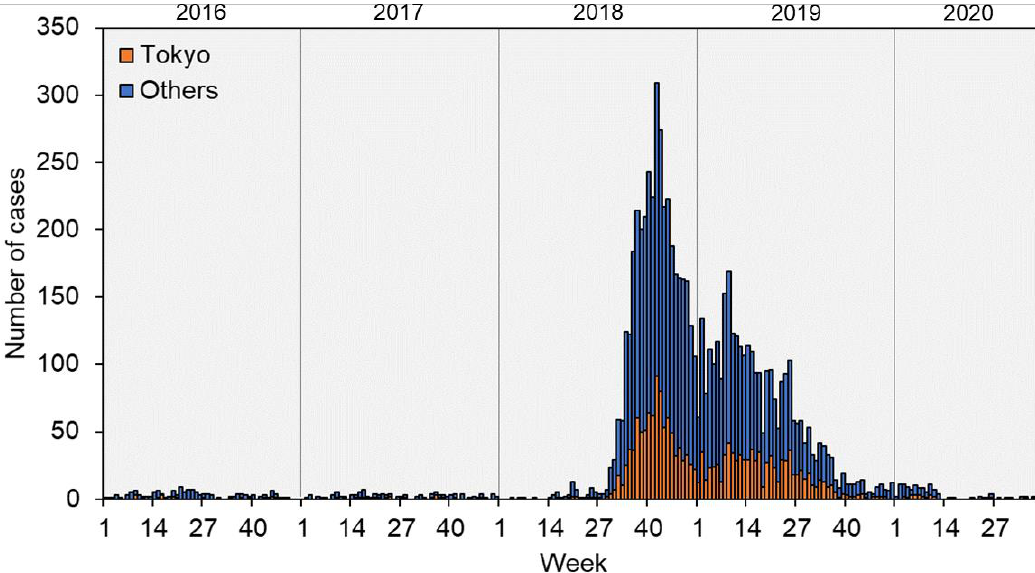
Figure 2. Epidemiological trend of rubella in Tokyo and all of Japan, by week, in 2016–2020. The orange represents the number of reported measles cases in Tokyo, while the blue indicates reported rubella cases outside Tokyo. In 2020, only weeks 1–39 are shown due to the availability of data.